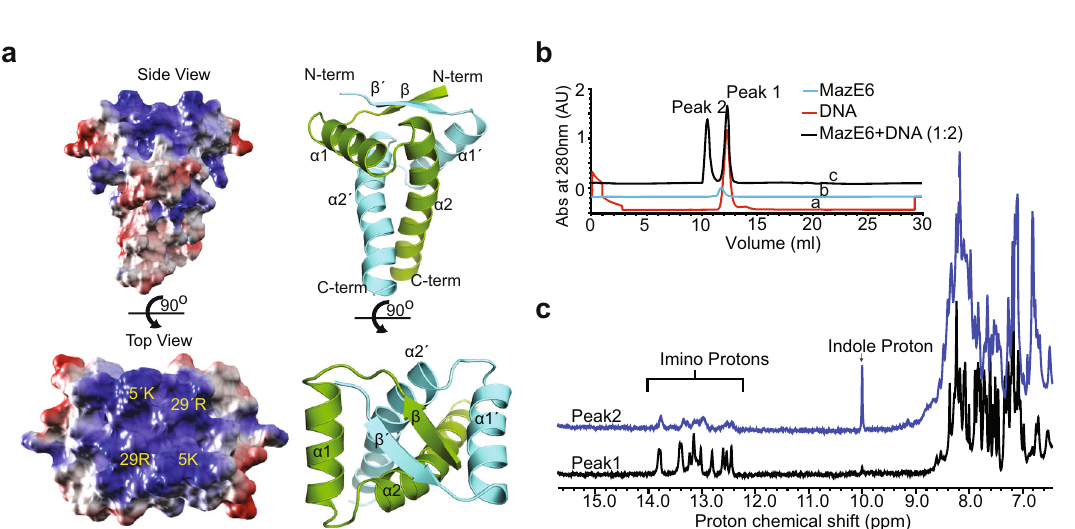
Fig. 4 Interaction of nMazE6 with operator DNA. a Side view and top view of surface charge potential of nMazE6 . The molecular surface having positive potential is shown in blue and negative potential is shown in red. Electrostatic surface was calculated and rendered using the Adaptive Poisson-Boltzmann Solver package within PyMOL. b Stacked plot of gel- fi ltration chromatograms of operator DNA (red), MazE6 (blue) and MazE6 + DNA (1:2) (black) on Superdex-S75 analytical column (24 mL). Comparison of the chromatograms shows that Peak1 and Peak2 in chromatogram ( c ) corresponds to DNA and MazE6-DNA complex respectively. Absorbance axis has been offset for clarity. c 1D Proton NMR spectra of analytes in Peak 1 and Peak 2. Molecular species present in Peak 1 corresponds to DNA (presence of characteristic imino protons between 12 and 14 ppm) and in Peak 2 corresponds to DNA + protein (presence of imino between 12 and 14 ppm and indole protons at 10 ppm, respectively). Line broadening of resonance line of imino protons in Peak 2 are indicative of complex formation. Similar pro fi les are observed for interaction between nMazE6 and DNA (Supplementary Fig. S7a). Source data are provided in the Supplementary Data